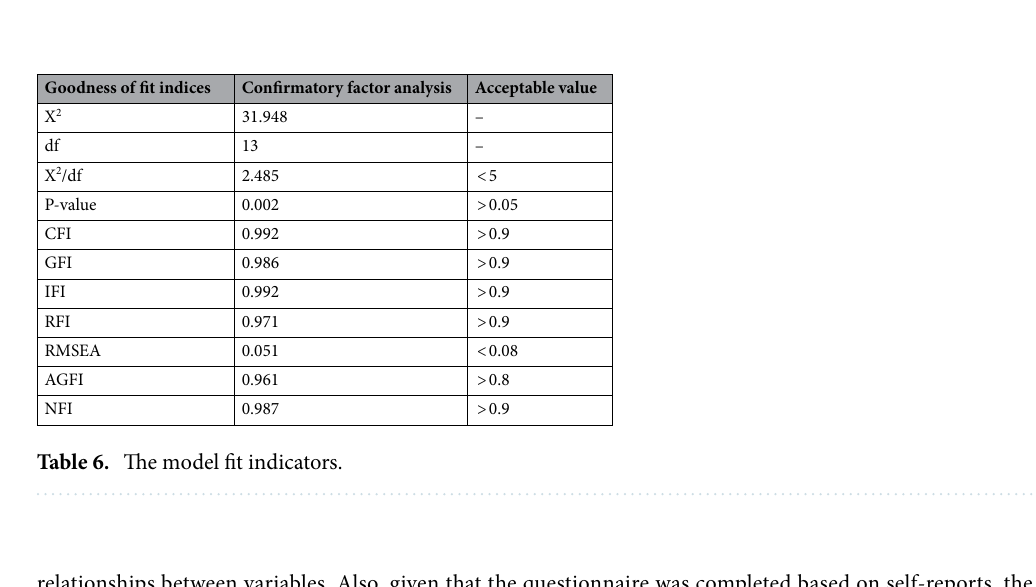
Table 5. Pearson correlation between psychological status, DHL, HLOC, and quality of life. * Significance level < 0.001.